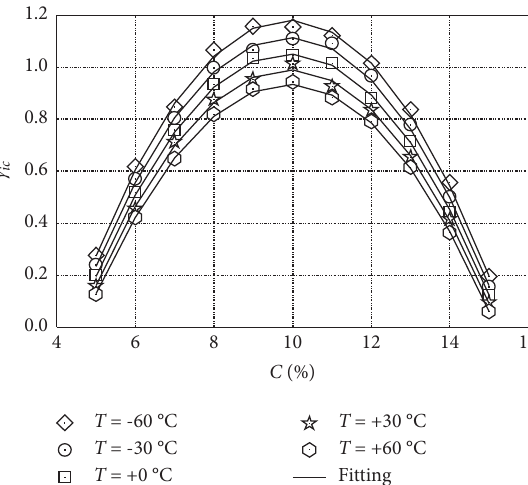
Figure 8: Relation among c